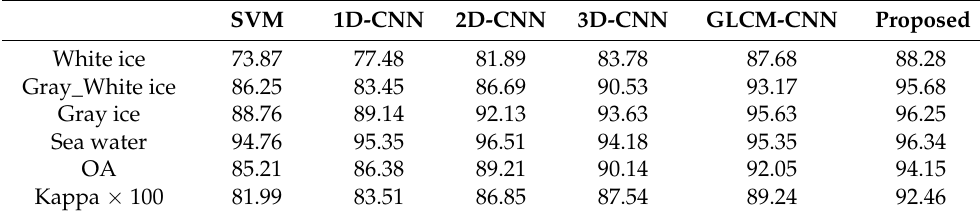
Table 5. Classification results (%) of the Bohai Bay data set.